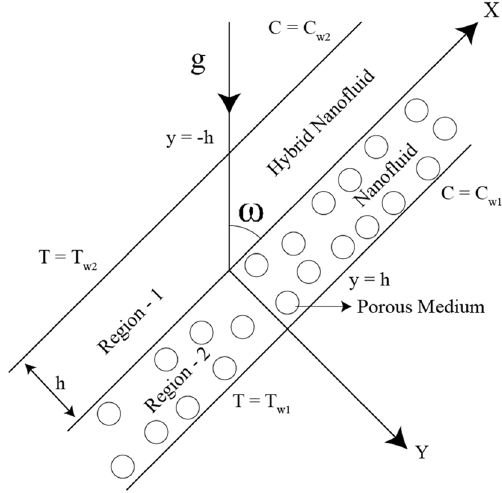
Figure 1. Physical model.